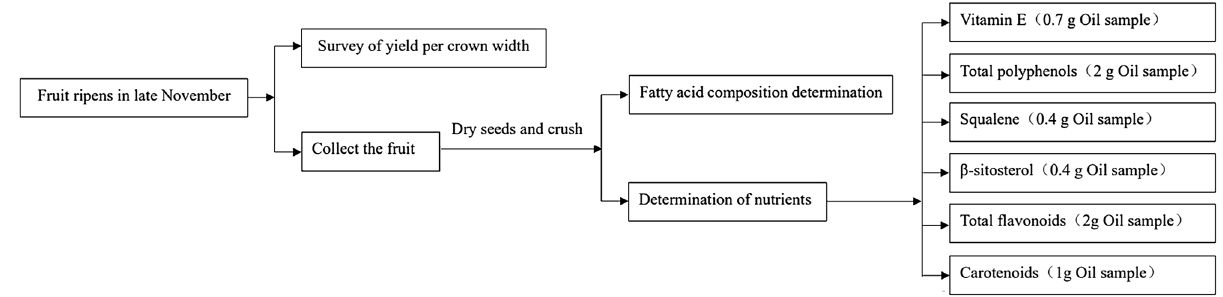
Figure 3. Schematic diagram of the study